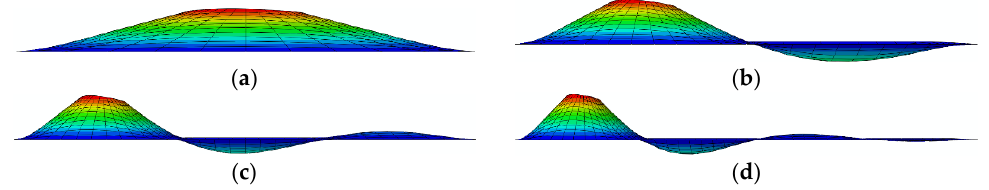
Figure 12. The model shapes of plates with e x / b = 0.5, BCs of 4S and different β from 1 to 4. ( a ) β = 1; ( b ) β = 2; ( c ) β = 3; ( d ) β = 4.